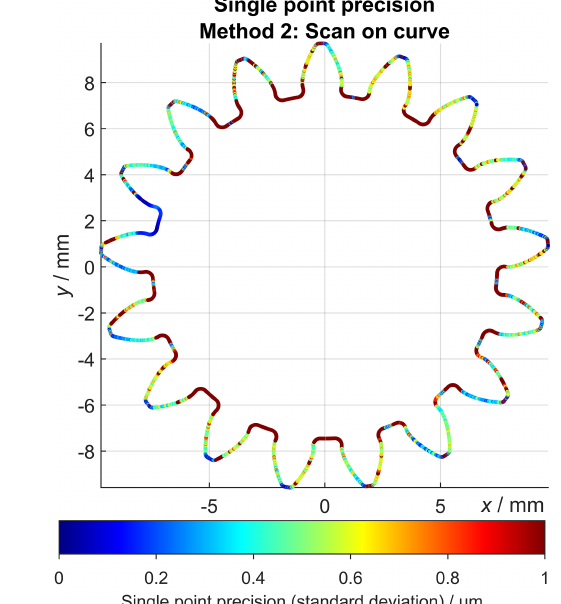
Figure 11. Single point precision (standard deviation) values for all sampling points of the nominal contour. See also the histogram visualization of the shown values in Fig. 12.